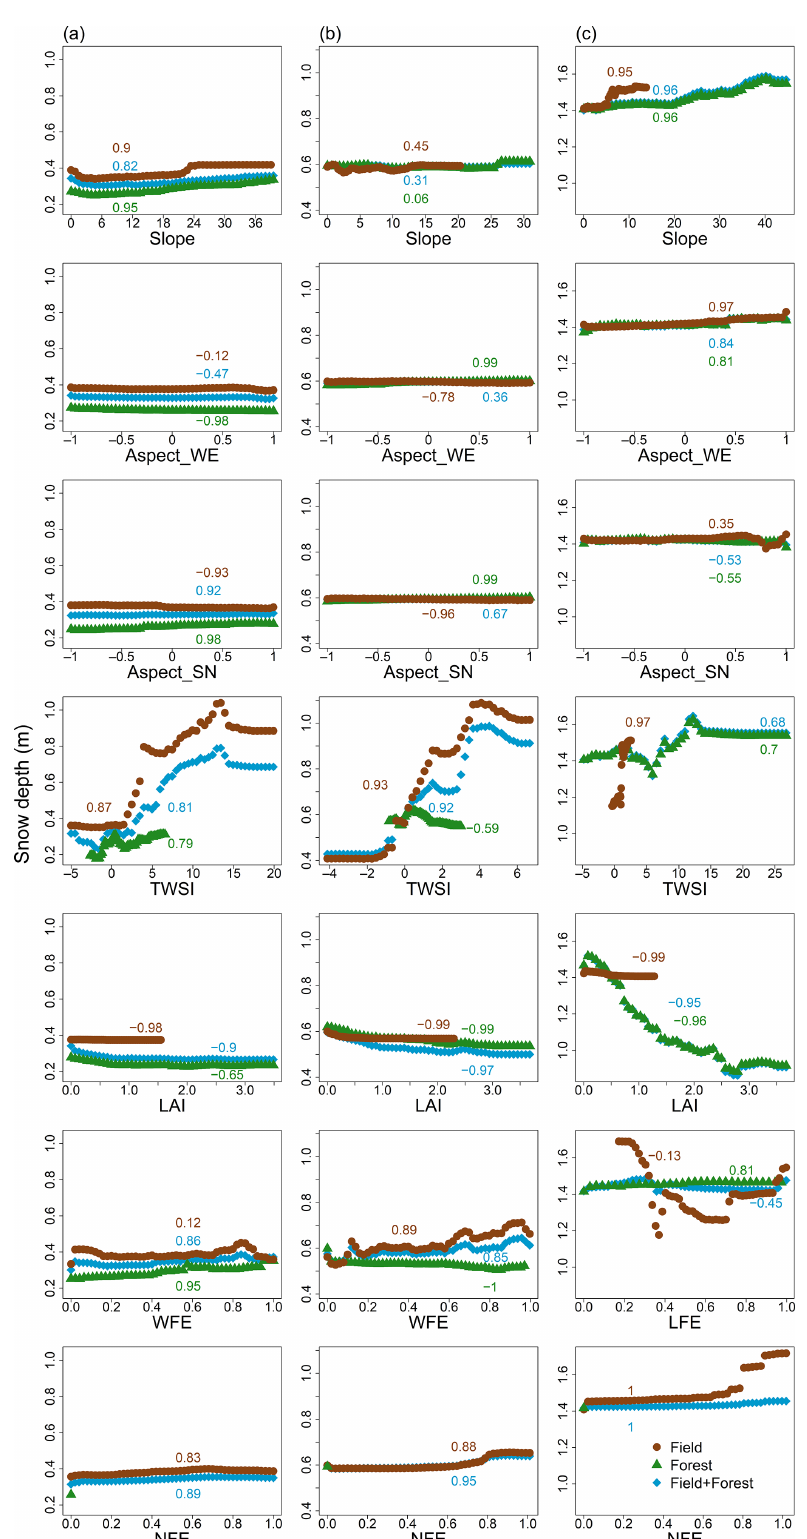
Figure 8. Partial relationship of landscape predictor variables with snow depth. (a) Sainte-Marthe, (b) Saint-Maurice, and (c) Montmorency. Predictor variables are presented by rows and sites by